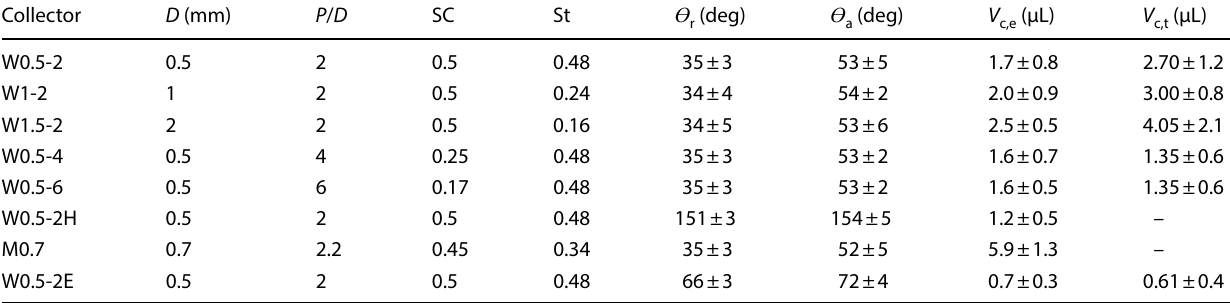
Table 1 Wire diameter ( D ), ratio of the center-to-center distance between wires to the wire diameter ( P / D ), shade coefficient (SC), and Stokes number (St), receding and advancing contact